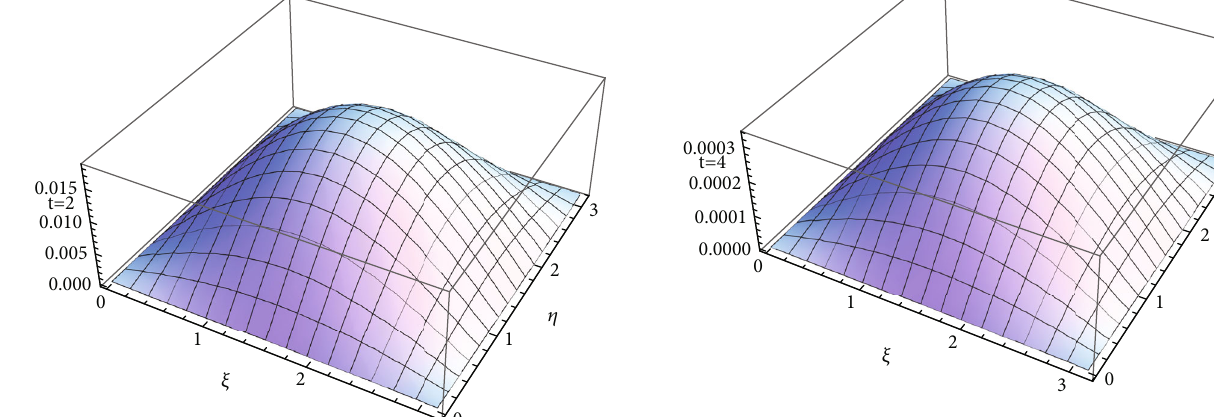
Figure 16: Approximate error for Example 9 at